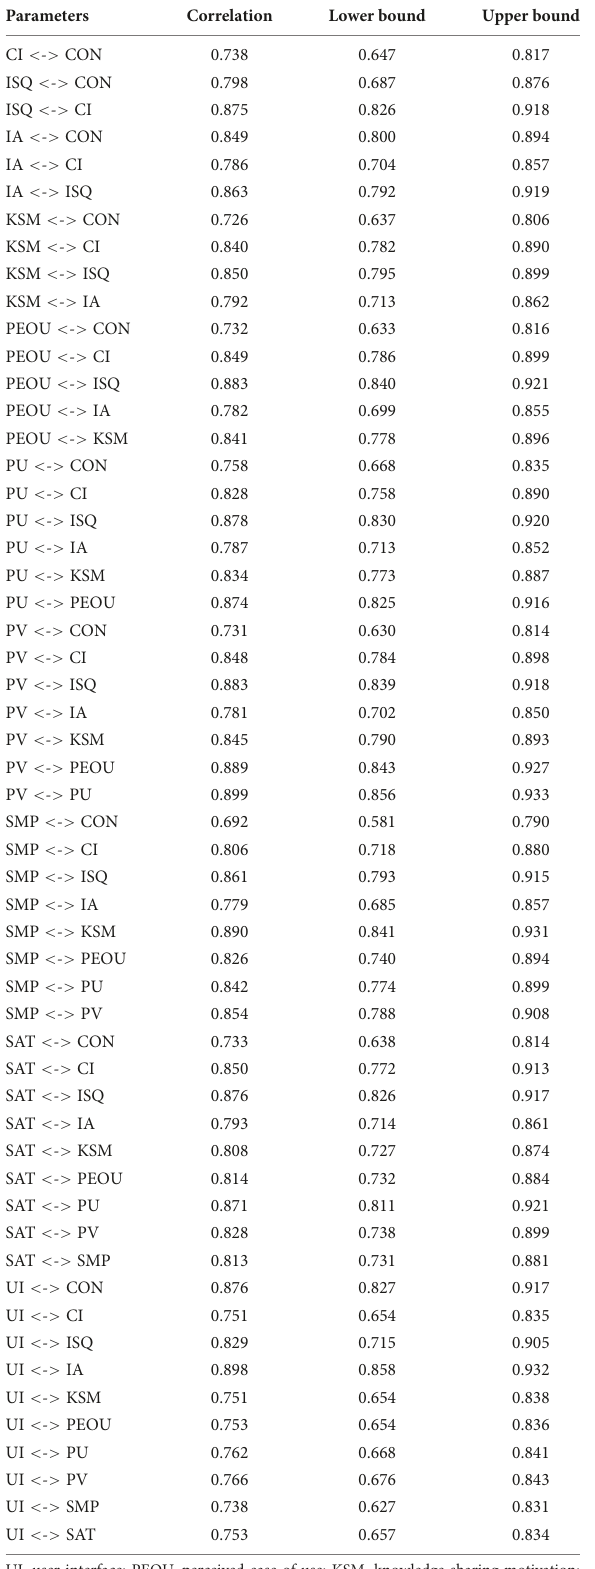
TABLE 2 95% confidence interval of